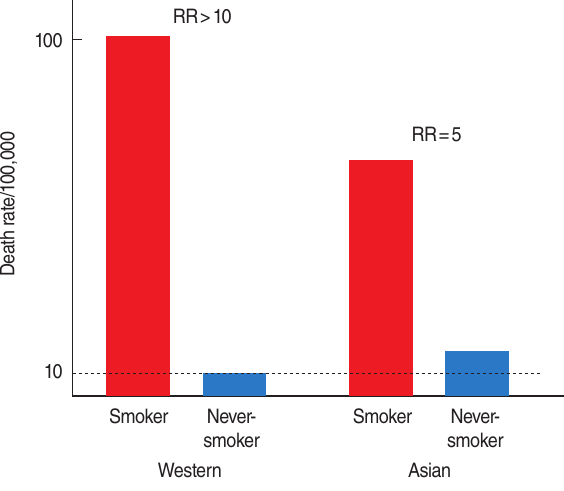
Figure 4. Hypothetical graph of relative risk (RR) in relation to death rate and smoking